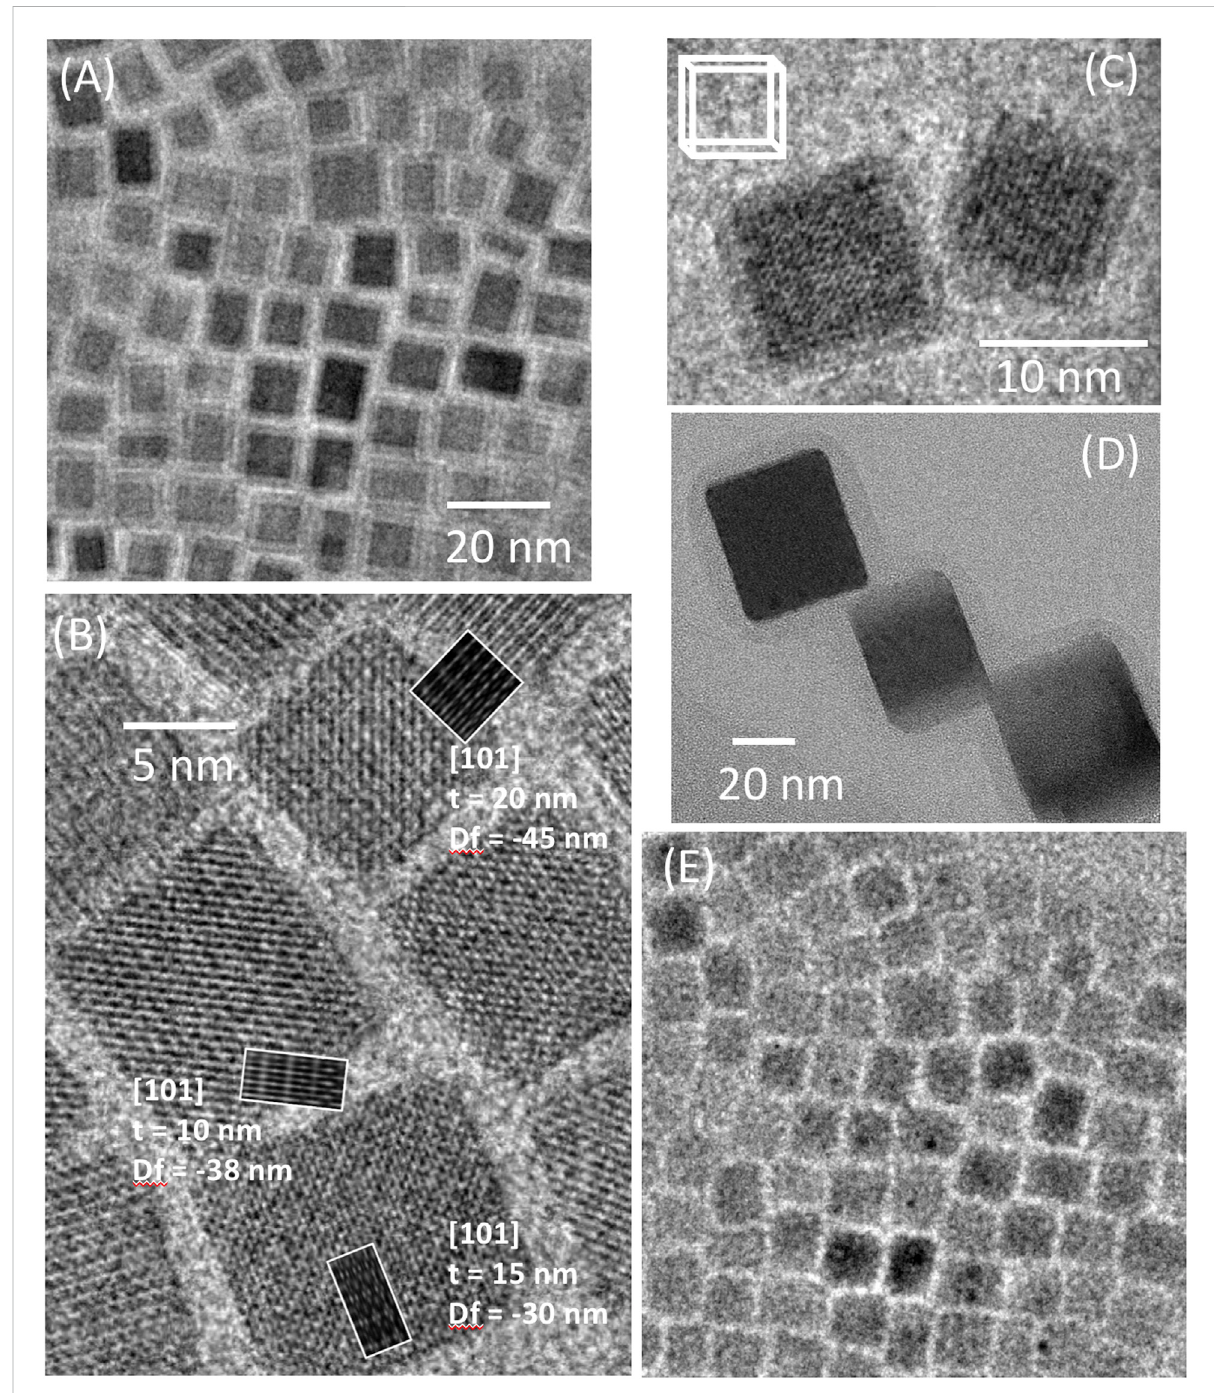
FIGURE 7 Low-dose TEM images of CsPbBr 3 nanocrystals. (A – C) Pb crystallites are not observed. In (A) , the tilt of the nanocubes (misalignment of the crystal faces of thenanocrystals with respect to theelectronbeam) leads to an arti fi cial “ core/shell ” structure. (B) High-resolutionimageof thesame sample without tilt; no “ shell ” is visible. (C) Image of a tilted nanocuboid. (D) Image of CsPbBr 3 /AlO x core/shell nanocrystals. (E) Same area as in (A) after repeated exposure (500 e − /Å 2 total dose). Note also the appearance of Pb